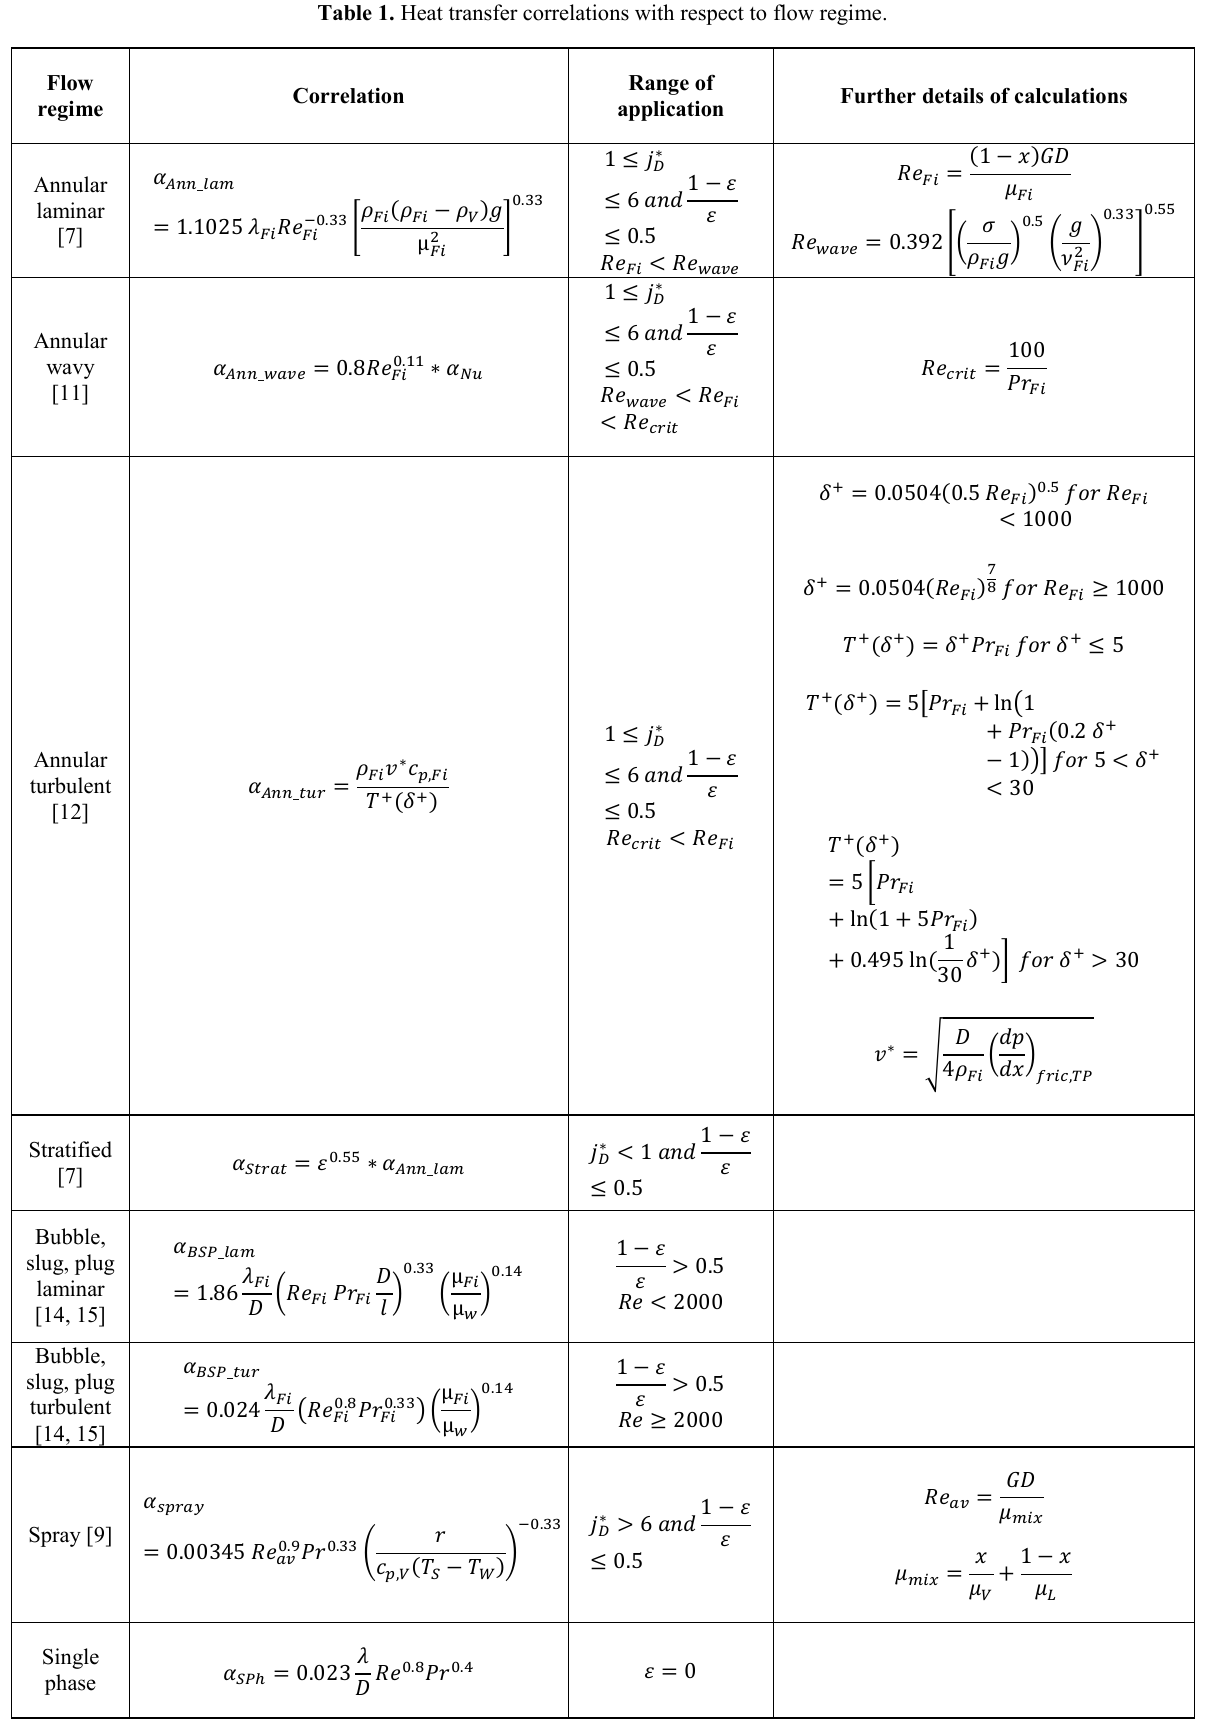
Table 1. Heat transfer correlations with respect to flow